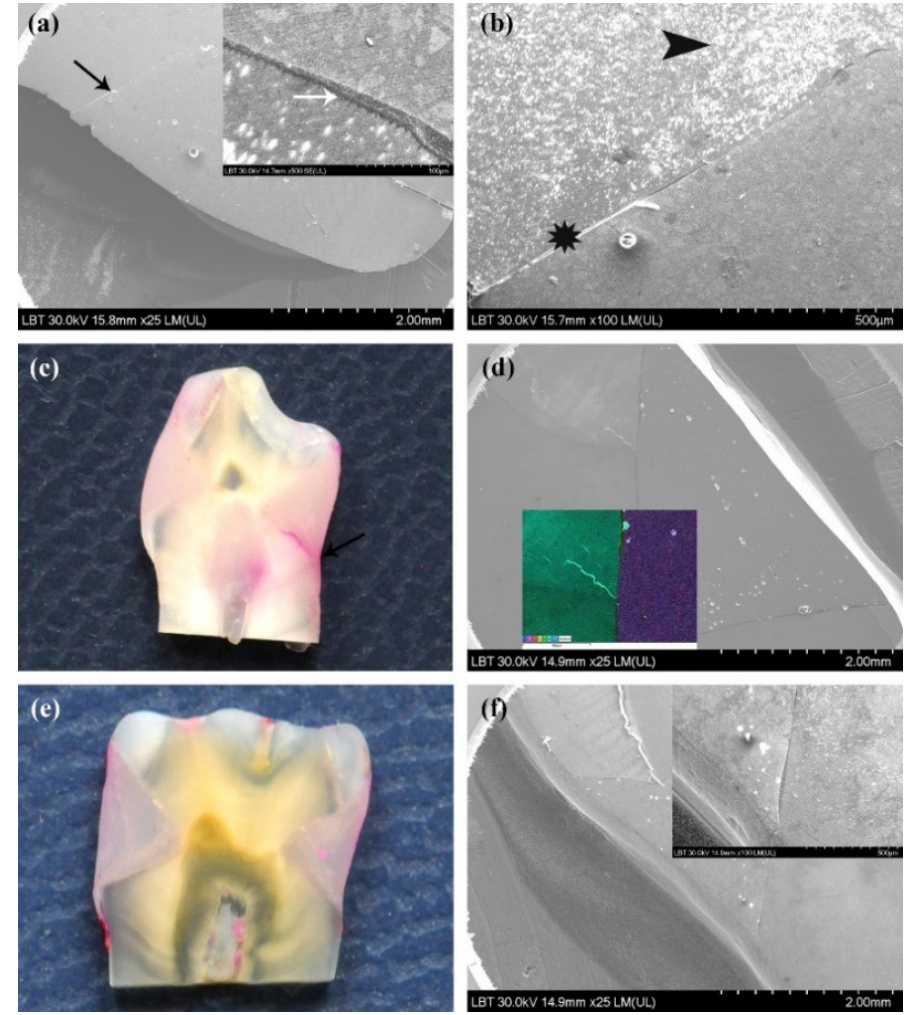
Figure 3. Beautiful II LS ® restorations. Cervical microleakage of a cementum-located restoration (25 × ) continuous with a dark-colored intact adhesive layer. Inset, resinous rete tags of about 5 µ m (500 × ) ( a ). Detail of the cervical cracked adhesive layer; dentin tubuli almost perpendicular to the surface (upper-left) (100 × ) ( b ). Infiltrated cementum-located restoration (right) corresponding to picture (a) and well-adapted enamel-located restoration (left) corresponding to picture d ( c ). Good cervical adhesion of an enamel-located restoration (lower right) and cracked occlusal enamel (upper left) not affecting the adhesive interface (25 × ). Inset, detailed fissures in occlusal enamel, green-colored dentin due to increased Ca, O, and P content, and purple-colored restoration due to Si, Al, and Sr content (50 × ) ( d ). Good cervical adhesion of a cementum-located restoration on tooth section (right) ( e ) and SEM (25 × ). Inset, detailed cervical intact adhesive layer (100 × ) ( f ). Black arrow, asterisk = microleakage; white arrow = resin tags, arrowhead = dentin tubuli.